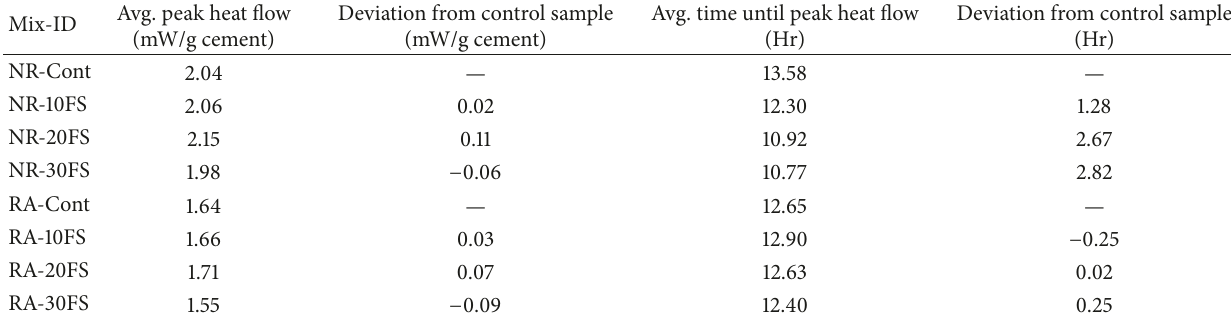
Table 6: Heat of hydration summary for concrete